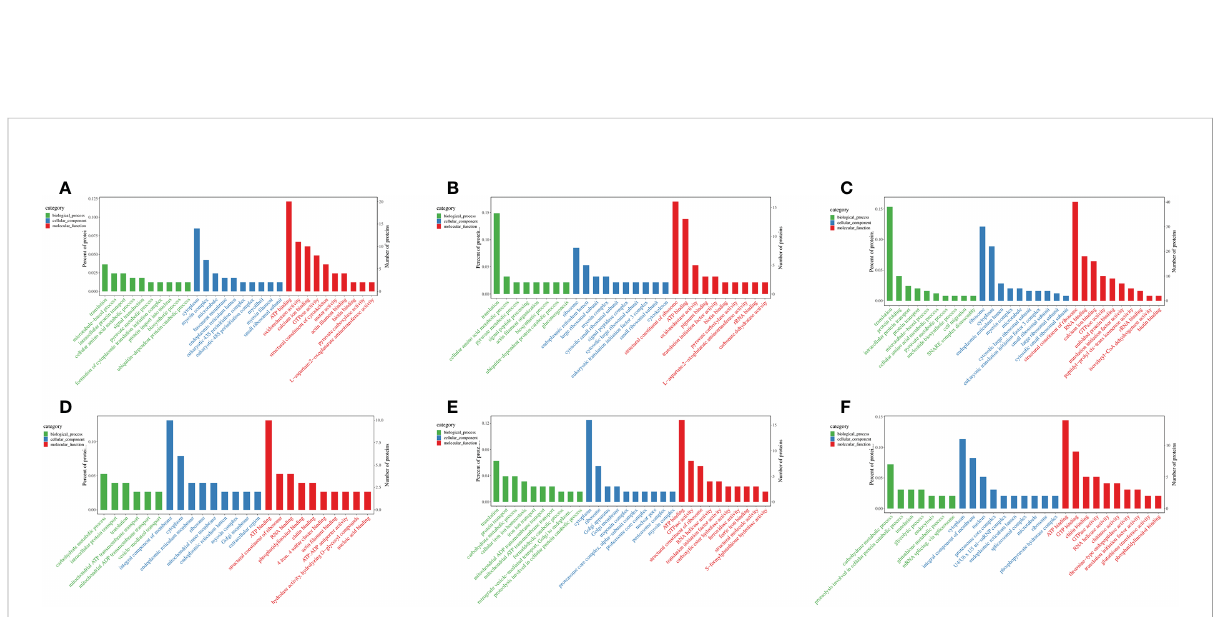
FIGURE 11 Results of the enrichment analysis of the gene ontology (GO) terms (Top 30) of DEPs of M.nipponense exposed to different salinity gradients in the gills (A – C) , and hepatopancreas (D – F) at 7, 14 and 21 ppt comparison treatments,